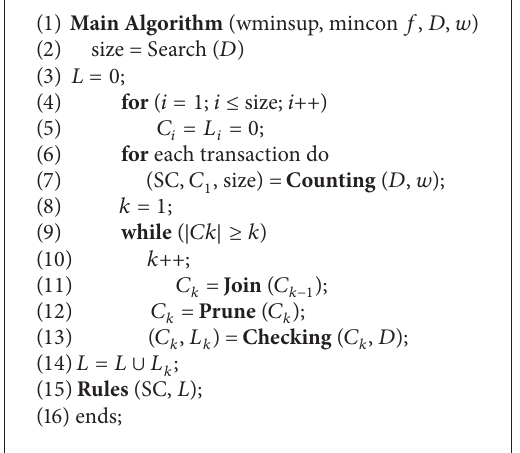
Algorithm 1: MINWAL algorithm [42].